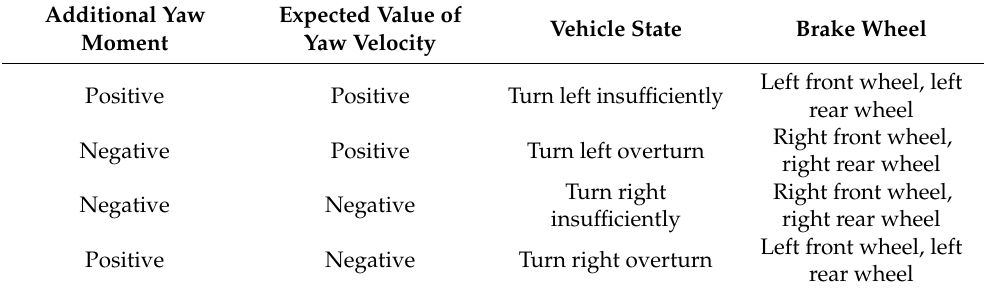
Table 2. Rules of braking force distribution of brake